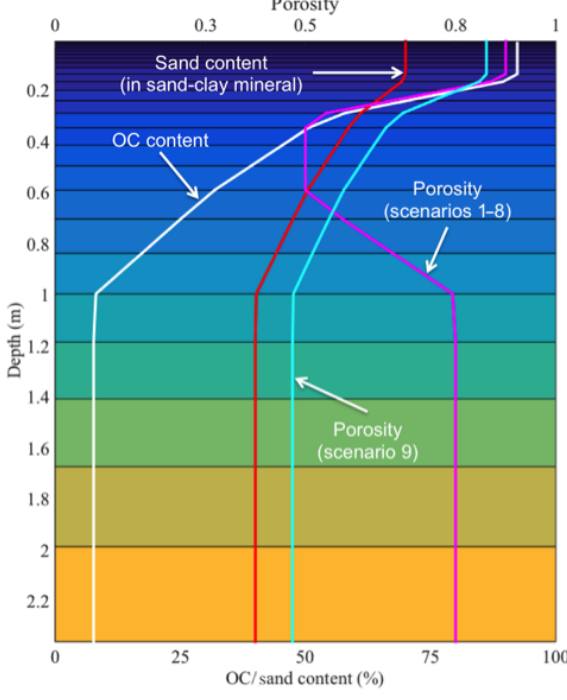
Figure 3. Twenty-seven synthetic soil layers and soil properties (OC, sand content and porosity) for simulating hydrological and thermal dynamics. The five bottom bedrock layers are not shown in this figure. We assumed that the vertical profiles of soil proper- ties are constructed by interpolating their corresponding values at z = 0 . 1, 0.3, 0.6 and 1m. For scenarios 1–8, the soil porosity was fixed ( (cid:56) = 0 . 9, 0.5, 0.5 and 0.8 for z = 0 . 1, 0.3, 0.6 and 1m, respec- tively). For scenario 9, the soil porosity was calculated from the OC and sand content ( (cid:56) = 0 . 86, 0.67, 0.57 and 0.47 for z = 0 . 1, 0.3, 0,6 and 1m, respectively).